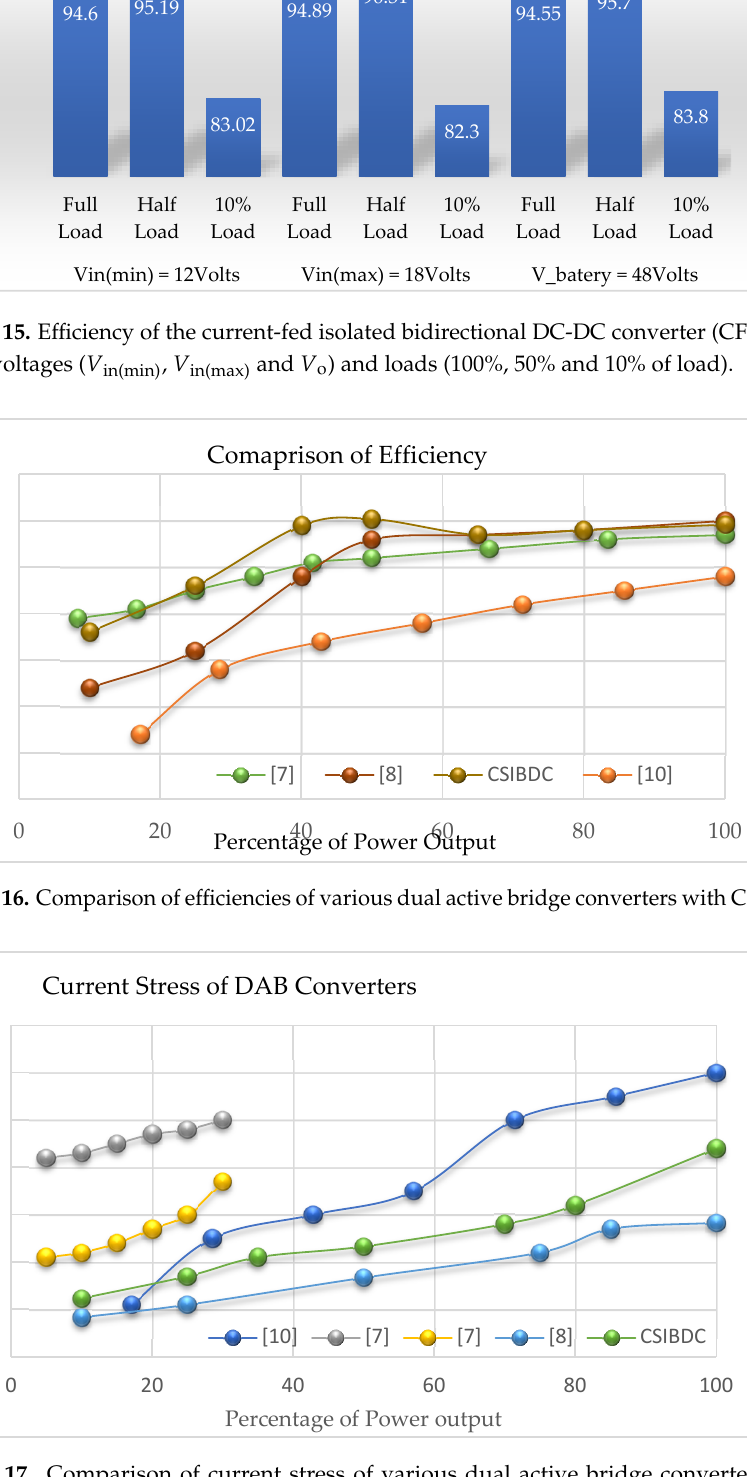
Figure 14. Conduction, turn-off, transformer and body diode losses of the CFIBDC converter at var-